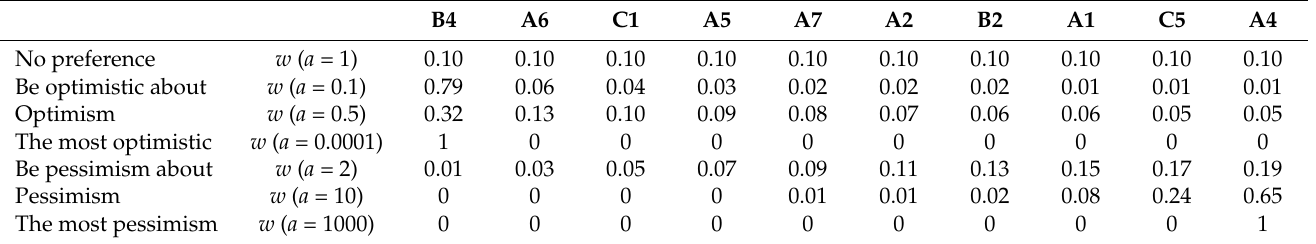
Table 5. Order weight calculation